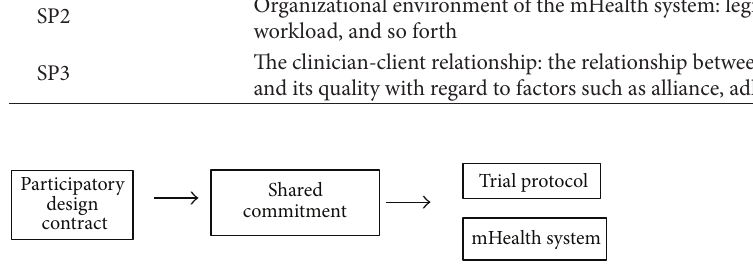
Figure 1: Model of the relationships identified in the analysis of the participatory design phase.